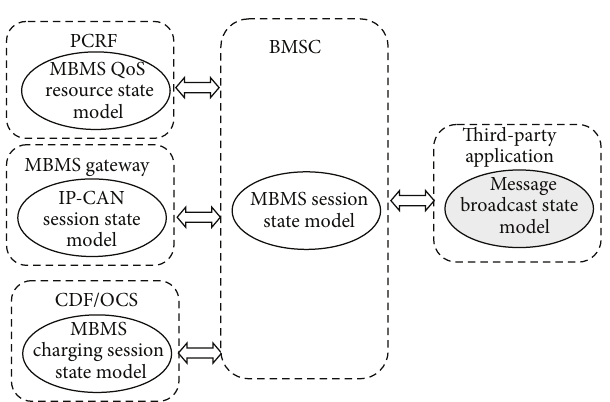
Figure 4: Synchronization of MBMS state models in the network and the 3rd-party application view on the message broadcast